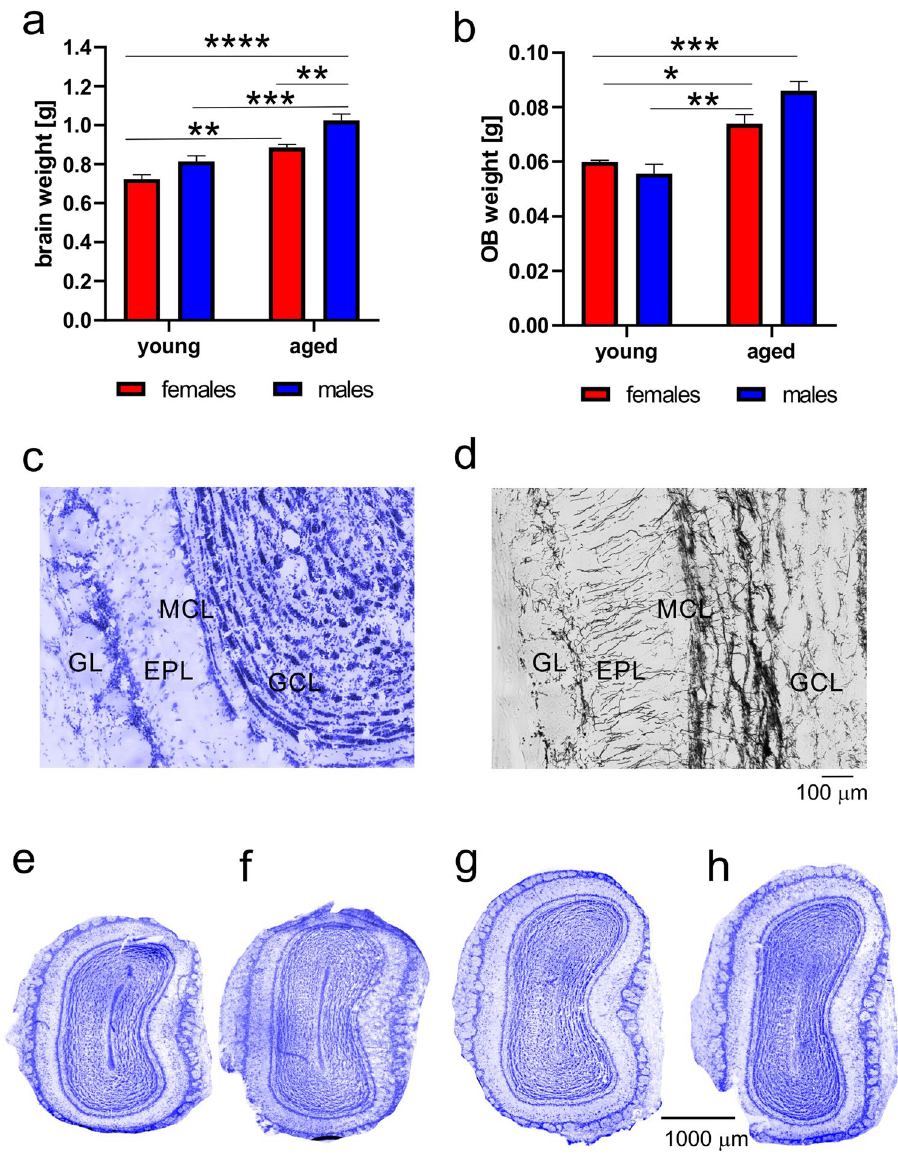
Figure 3. Brain and olfactory bulb (OB) weights of young and aged opossums, and cyto- and myelo- architectonic characteristics of the OB. ( a , b ) Quantification of brain ( a ) and olfactory ( b ) weight measures in young and aged opossums of both sexes. ( c , d ) Cyto- ( c ) and myelo- ( d ) architectonic properties of the OB. ( e – h ) Coronal Nissl-stained OB sections in young female ( e ), young male ( f ), aged female ( g ) and aged male ( h ) opossums. GL glomerular layer, EPL external plexiform layer, MCL mitral cell layer, GCL granule cell layer. In ( a , b ) * p < 0.01; ** p < 0.001; *** p < 0.0001, **** p < 0.00001. The scale bar in ( d ) refers to ( c ), and the scale bar in ( h ) refers to ( e – h